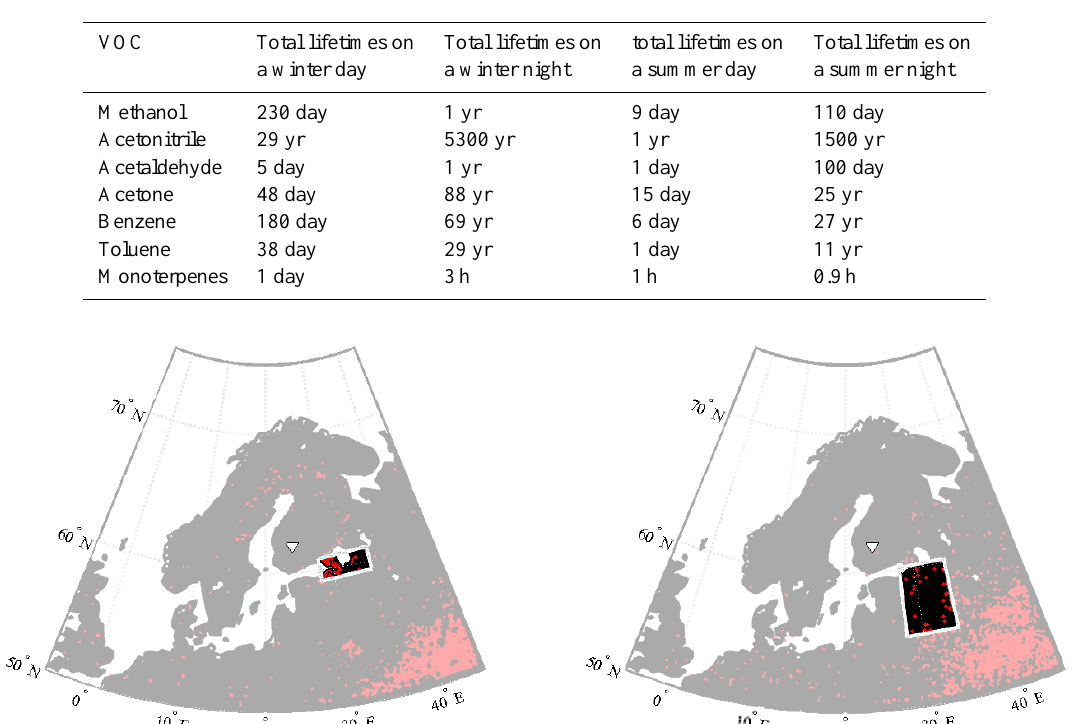
Table 4. Total atmospheric lifetimes ( e -folding times) of the VOCs studied, daytime and night-time in summer and winter. Daytime values are the sums of lifetimes calculated towards O 3 , OH and photolysis. Night-time values were calculated towards O 3 and NO 3 .